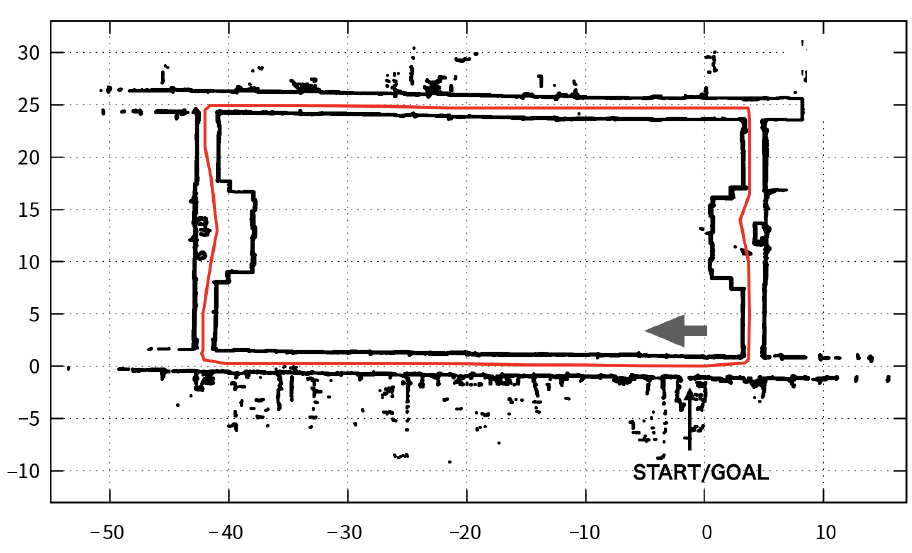
Figure 8. The Map and predefined path for the experiments.